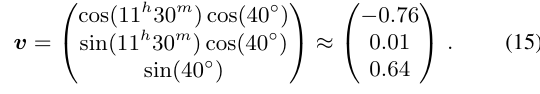
Figure 6. Nightsky over Munich (Image by Stellarium, 2018). A corner of the building (green) and the LNB of the satellite dish (red) are marked with dots. From the perspective of the image the corner of the building (green dot) is seen in front of the night sky at the right ascension of about 11 h 30 m and declination of about 40 ◦ on the celestial coordinate system, and the LNB (red dot) is seen at the right ascension of about 14 h 10 m and declination of probably 47 ◦